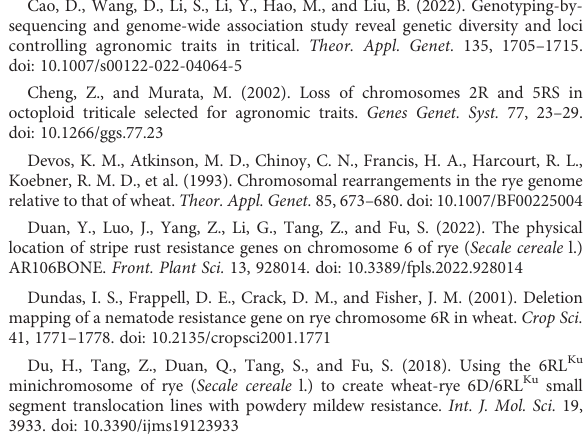
SUPPLEMENTARY FIGURE 1 Sequential ND-FISH of T-701 (A, D) Sub6R(6D) (B, E) and T6DS.6RL line R23 (C, F) with Oligo-pSc119.2 + Oligo-pTa535 (A, B, C) and Oligo-248 (D, E, F) respectively. The arrows point to the FISH signal of Oligo-248 in the terminal region of 6RL. SUPPLEMENTARY FIGURE 2 Different types of wheat-6R chromosome translocations were identi fi ed in the M3 progenies using ND-FISH. Oligo-Ku and Oligo-D (A) and Oligo- pSc119.2 + Oligo-pTa535 (B) were used to show chromosome T5DS.5DL-6RL (A, B) . Different types of translocations were showed in (C) , with breakpoints indicated by arrowheads (C) . SUPPLEMENTARY FIGURE 3 The stripe rust responses of deletion lines R266, R367, and R76, translocation line R23, and substitution line Sub6R(6D). All three deletion lines were susceptible, whereas the translocation and substitution lines were highly resistant. SUPPLEMENTARY FIGURE 4 FISH patterns of chromosome 6R by ND-FISH with Oligo-pSc119.2 (green) + Oligo-pSc200 (red) as probes. Three different karyotypes were observed for cultivated rye, which were distinctively different from S. africanum